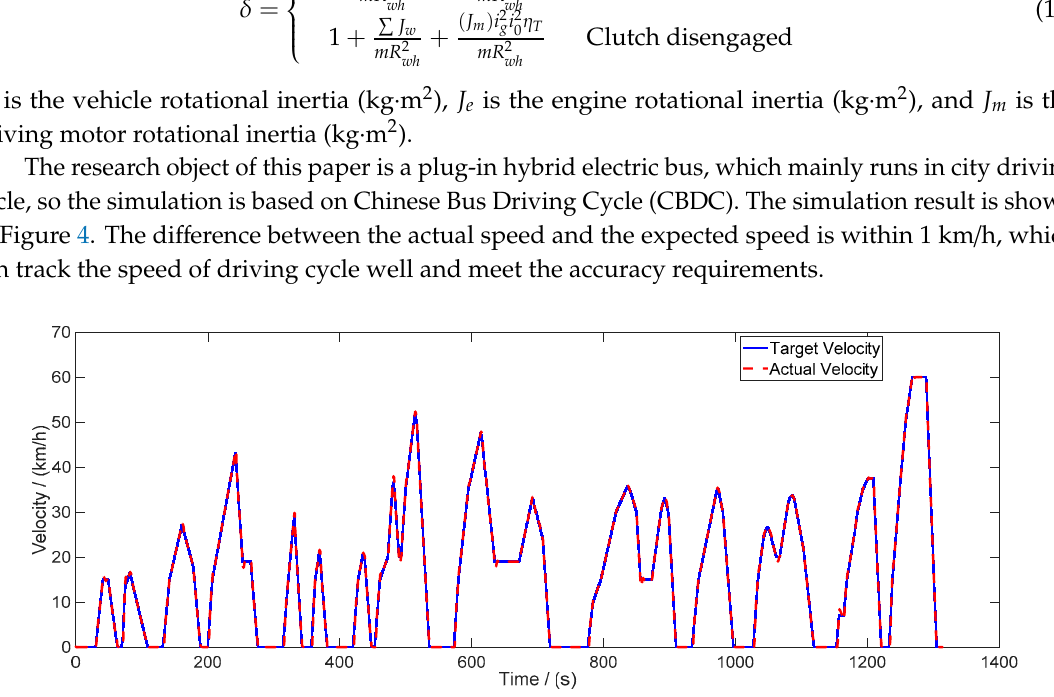
Figure 4. Simulation result of vehicle speed in Chinese Bus Driving Cycle (CBDC).